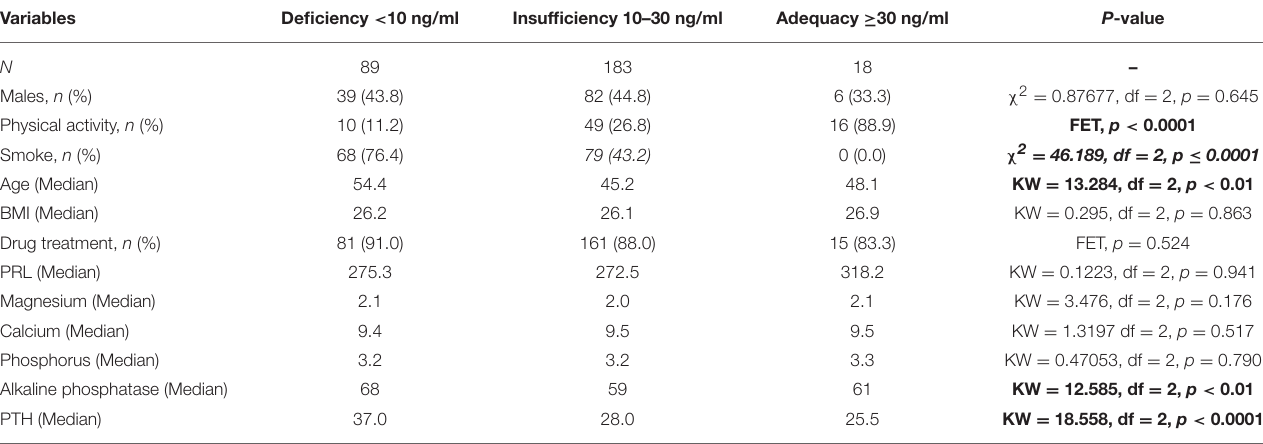
TABLE 1 | Demographic and clinical characteristics of study participants according to vit D